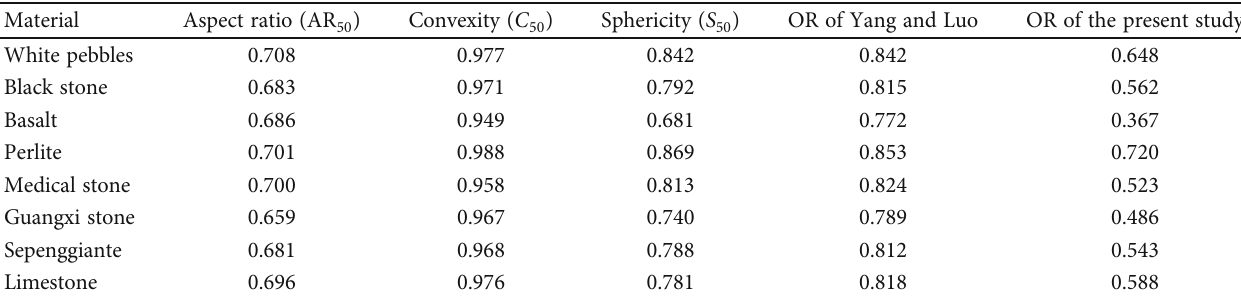
Table 3: The 50% cumulative distribution data of the eight materials.